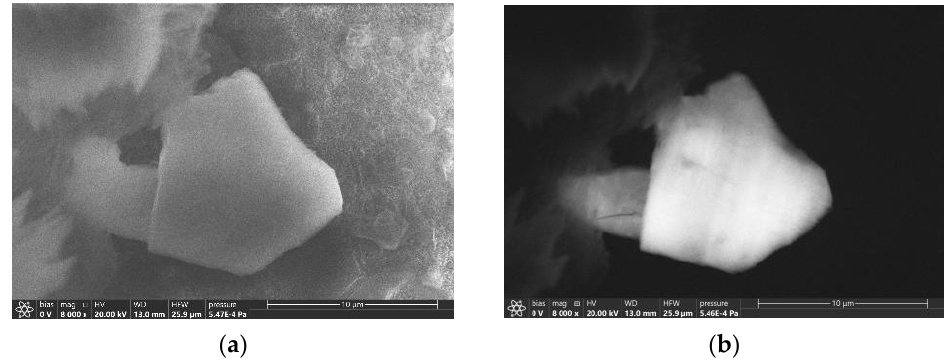
Figure 11. SEM images of a B-Hq-Dir(493) BLC preparation fabricated by direct synthesis at 20 kV accelerating voltage: ( a ) SEM image, ( b ) total cathodoluminescence.